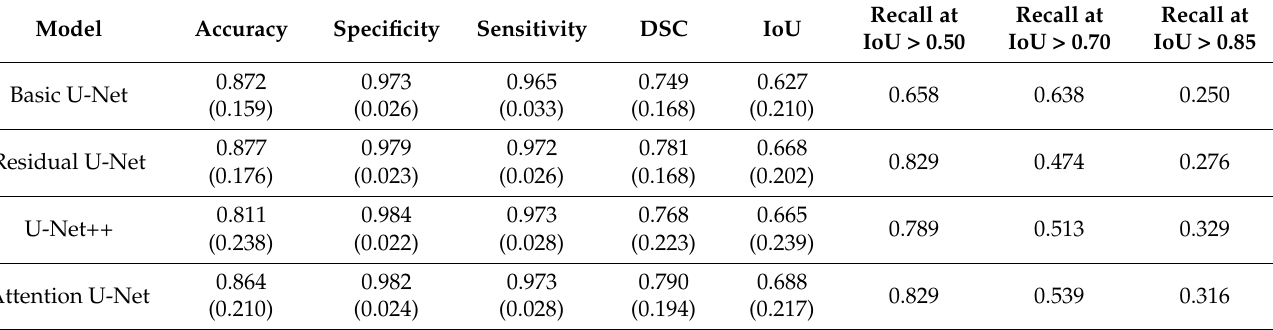
Table 5. Performance comparison of the deep-learning models for pancreatic cyst lesion segmentation on the internal test of the cross-over study. The mean of performance is shown with the standard deviation in parentheses on the accuracy, specificity, sensitivity, dice similarity coefficient, and intersection over union. A recall score greater than the threshold is